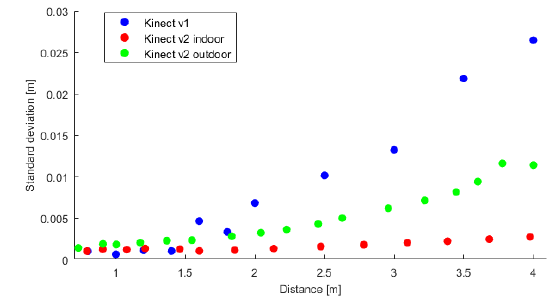
Figure 3. Standard deviations of the depth measurements the object and the